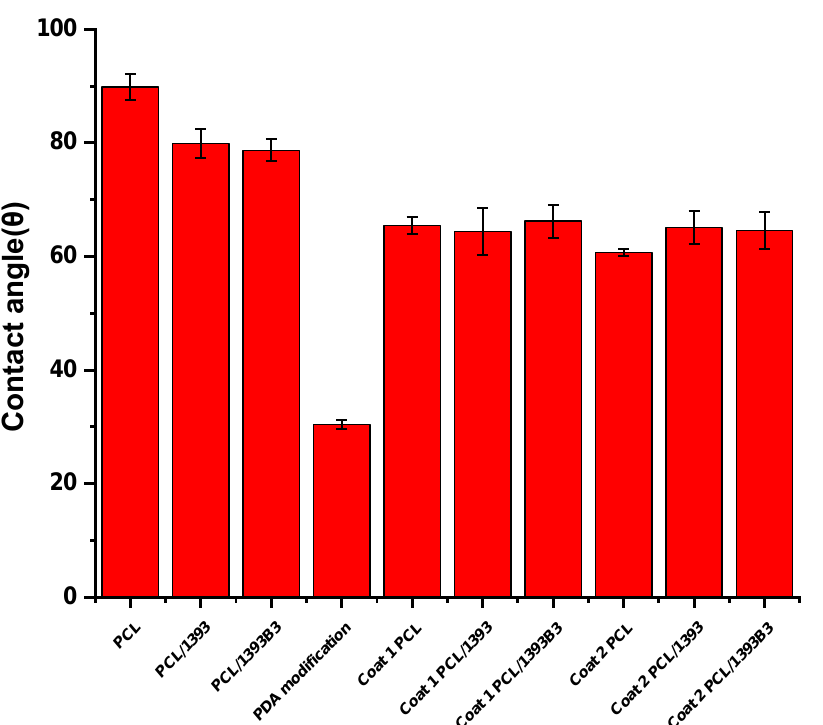
Figure 2. Comparison of contact angles of scaffolds before and after coatings.